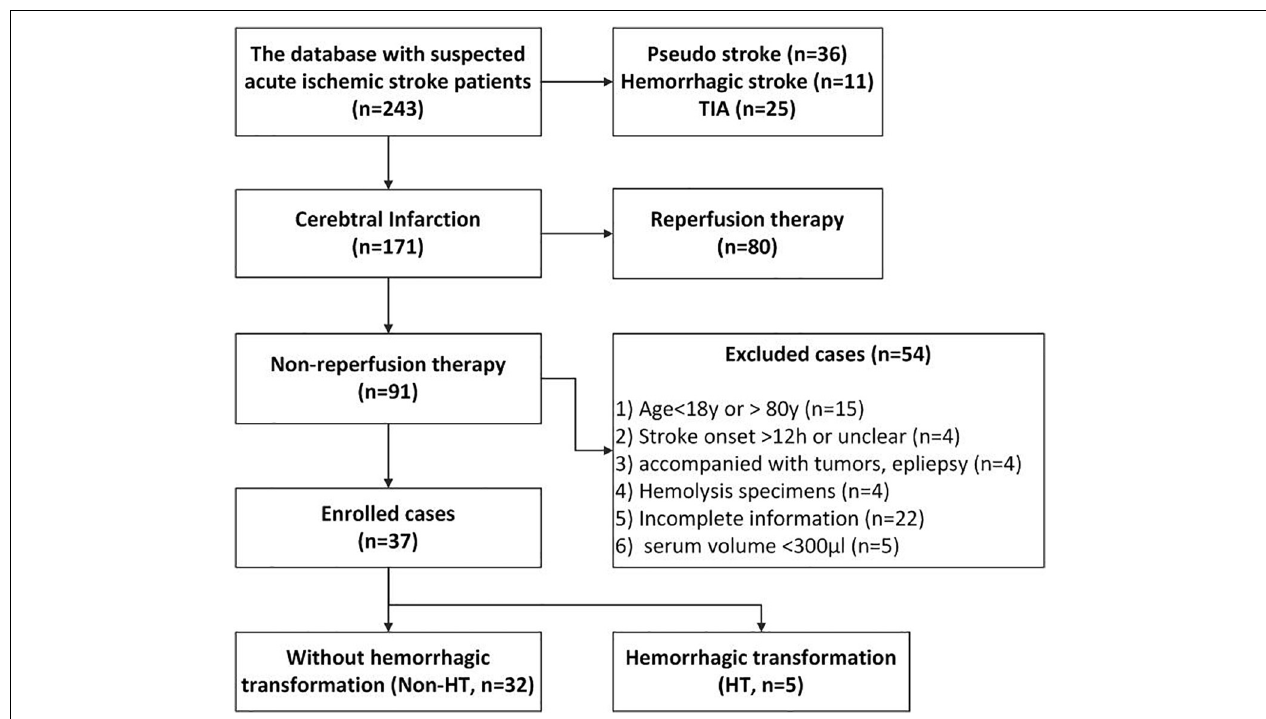
FIGURE 1 | The flowchart of case enrollment. We obtained the clinical data and serum specimens from a database that was established in our previous study. This database includes 243 suspected acute ischemic stroke (AIS) patients who were administered at the emergency room at Xuanwu Hospital from November 2018 to March 2019. In this study, we enrolled the 37 AIS patients [hemorrhagic transformation (HT), n = 5; non-HT, n = 32] based on our inclusion and exclusion